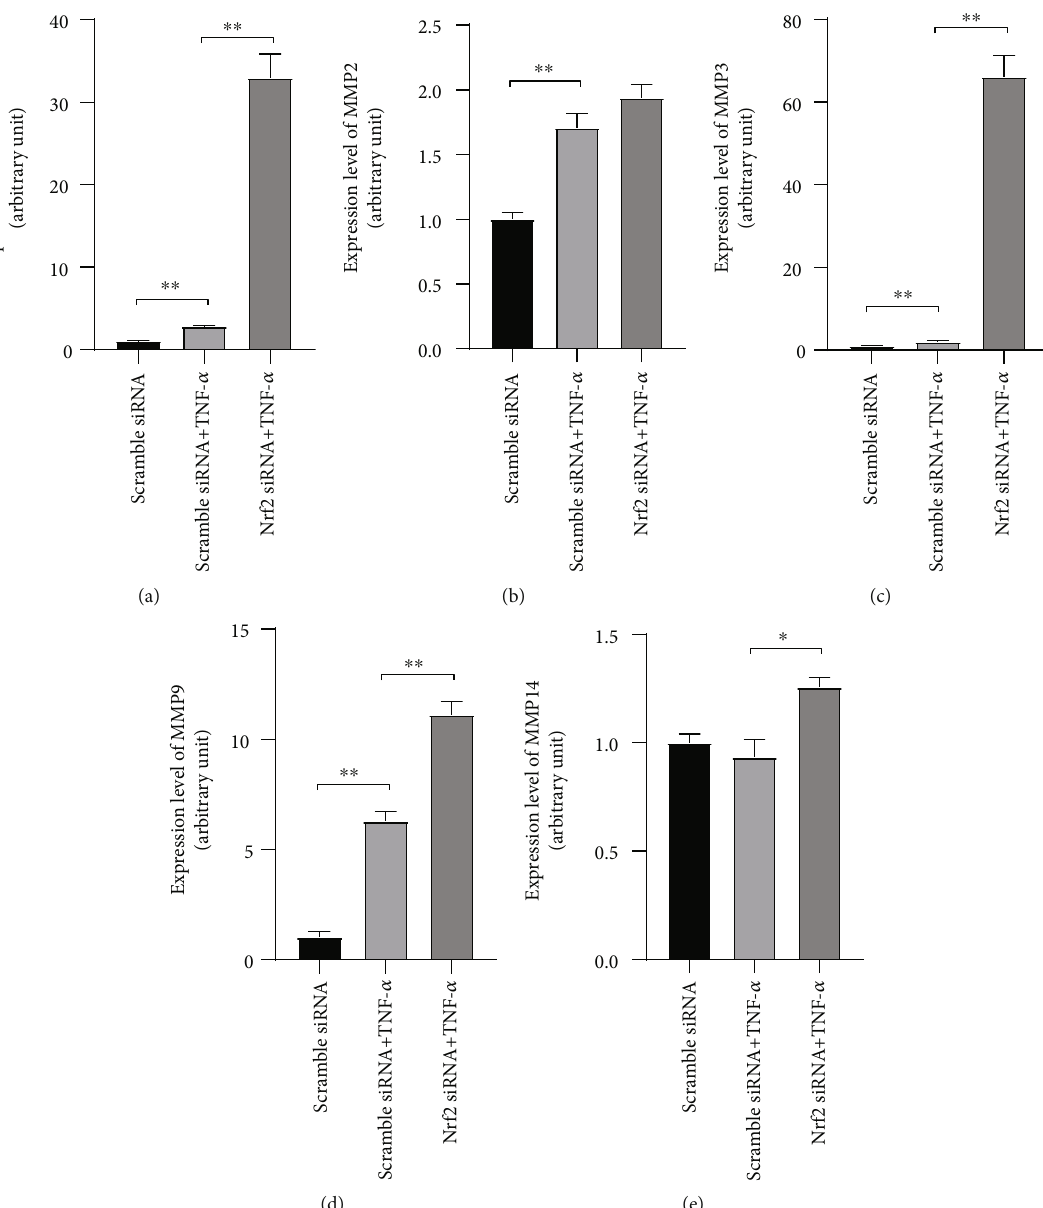
Figure 5: Knockdown of nrf2 promoted TNF- α -induced matrix metalloproteinase (MMP) expression. After transfection with scramble siRNA or nrf2 siRNA for 3 days, RA-FLS were stimulated with/without TNF- α (25 ng/mL) for 24h. The expression of MMP1 (a), MMP2 (b), MMP3 (c), MMP9 (d), and MMP14 (e) was examined with real-time PCR. N = 3 . Data were shown as the mean ± SD ; ∗ p < 0 : 05 and ∗∗ p < 0 : 01